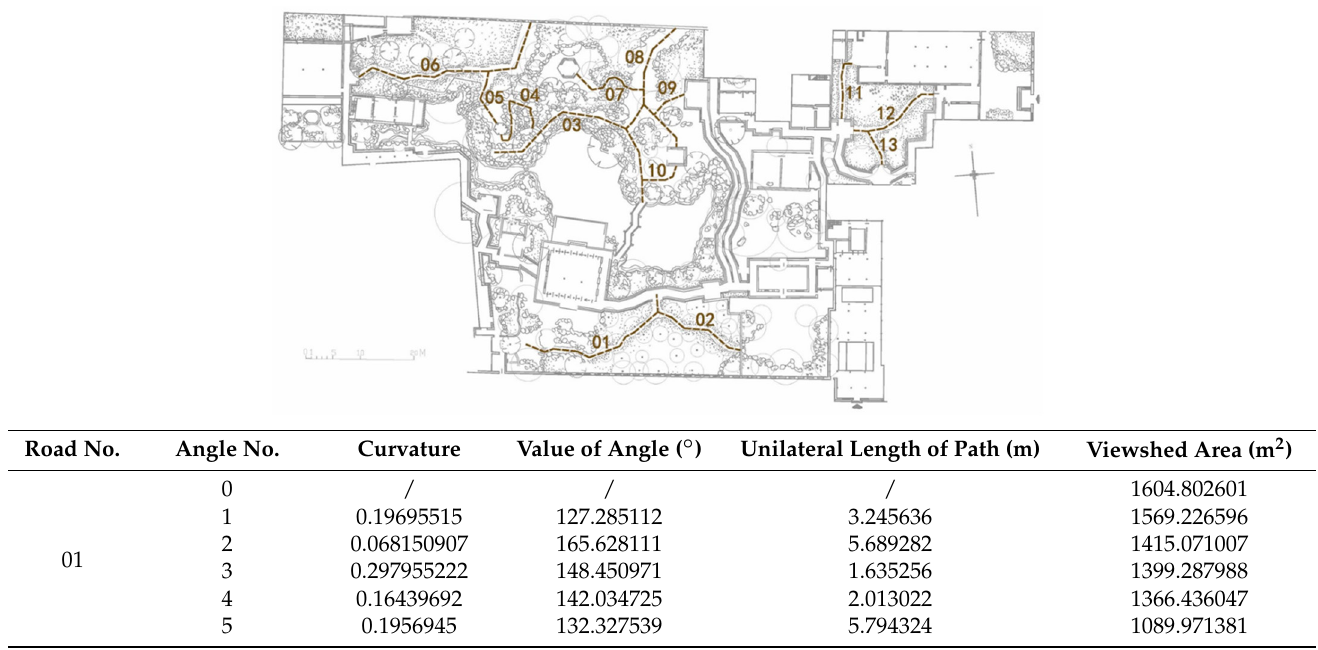
Table A6. Garden of Harmony, garden path.